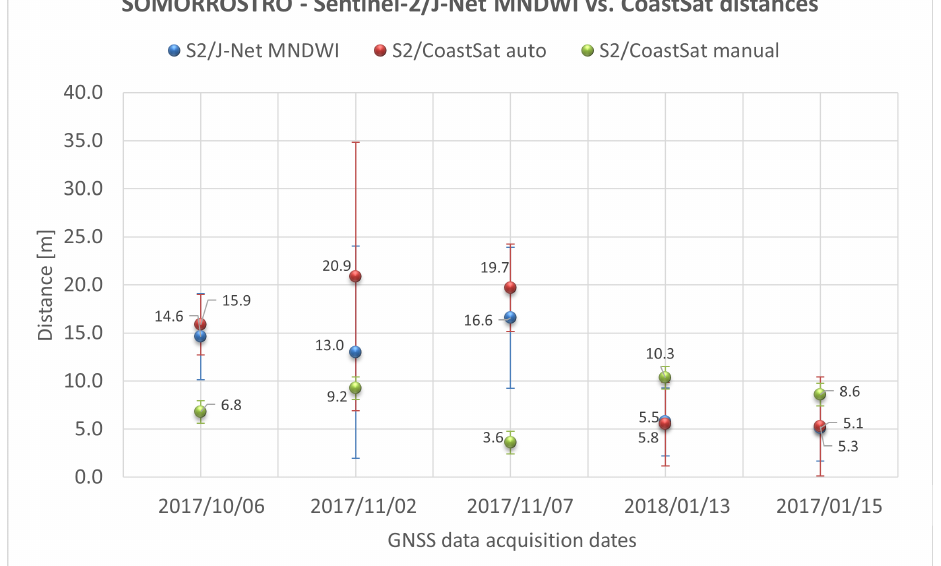
Figure A6. Comparison between the mean distance and standard deviation for each date on Sentinel-2 imagery considering J-Net Dynamic plus MNDWI algorithm and CoastSat with automatic and manual thresholds in